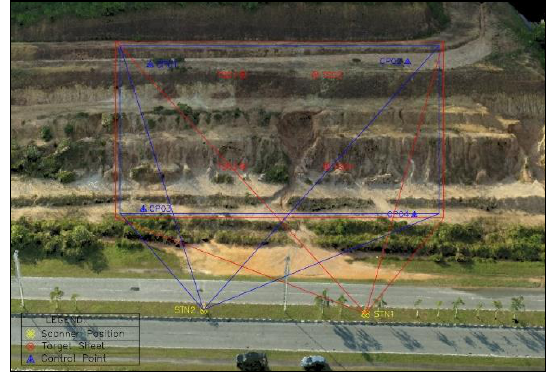
Table 4. The selection of target sheet is based on the scanning distance